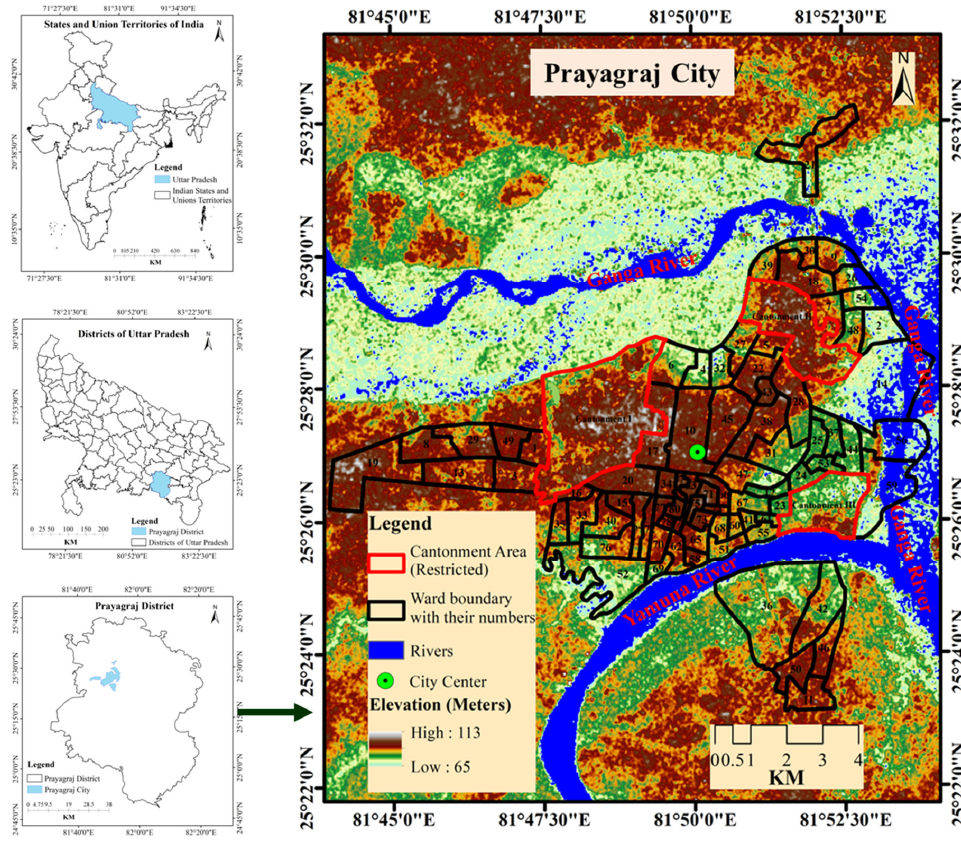
Figure 1. Map of Prayagraj city (India). Table 1. Summary of the data